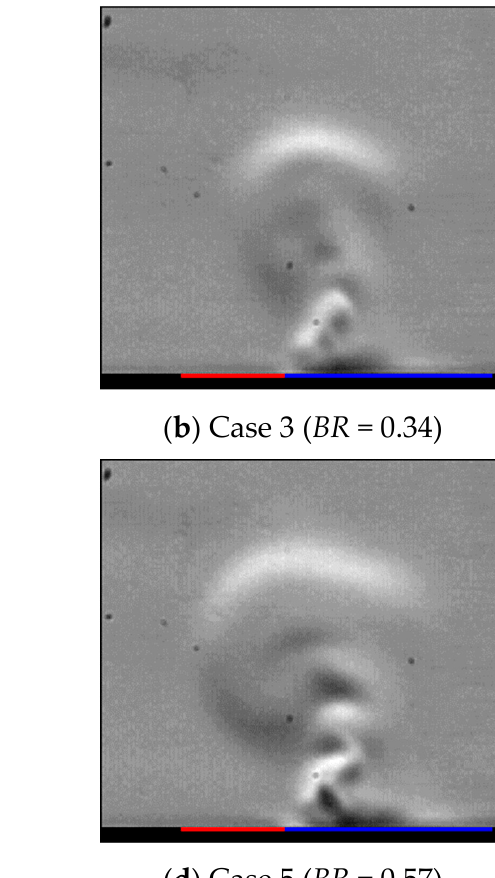
( c ) Δ t = 3.0 ms Figure 7. Temporal variation of the hot plume during the first burst event (Case 5, BR = 0.57). Although the number of the thermal patterns is not the same as the number of the plasma